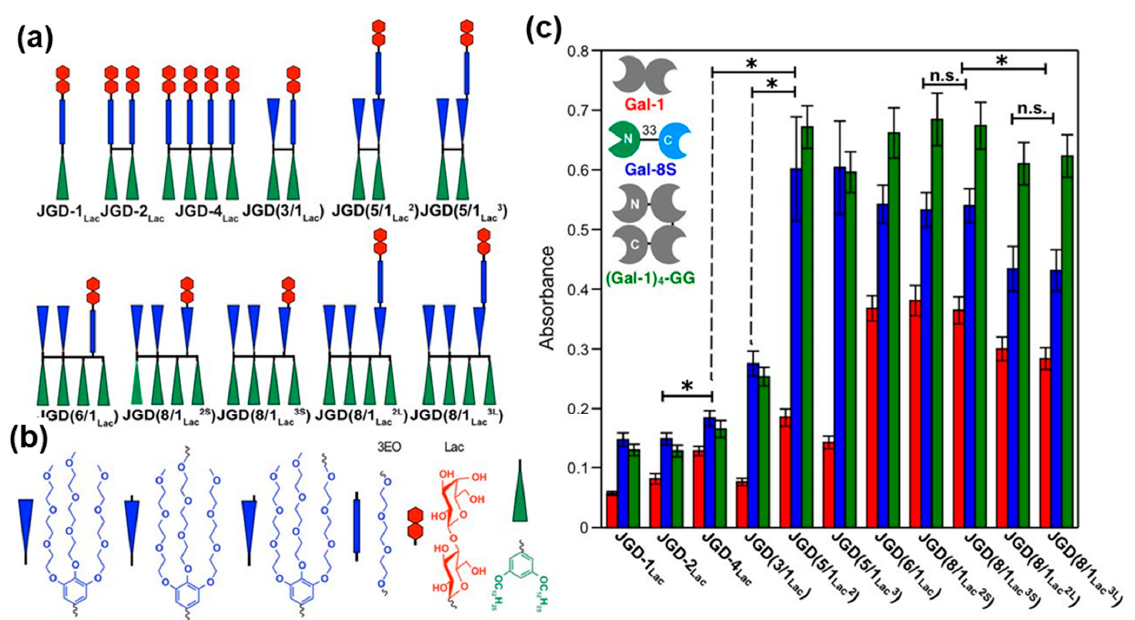
Figure 21. Encoding biological recognition in a bicomponent cell-membrane mimic. (a) Sequence- defined JGDs with different Lac densities, sequence, and linker length. (b) Schematic representation of JGD building blocks. (c) Summary of aggregation assay data using GDSs from self-assembly of sequence-defined JGDs (Lac = 0.1 mM, 900 µ L) with Gal-1 (1 mg · mL − 1 , 100 µ L), Gal-8S (1 mg · mL − 1 , 100 µ L), and (Gal-1)4–GG (1 mg · mL − 1 , 100 µ L). Color codes for galectins: Gal-1, red; Gal-8S, blue; (Gal-1)4–GG, green. N and C represent the N and C termini of proteins. For selected examples symbols used for significant difference ( p values by Student’s t-test) are: “n.s.” for p > 0.05 (for